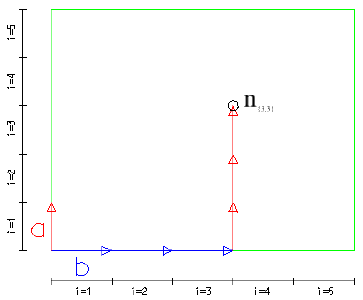
Figure 5. Method for determining a single point of view. Source: own work.